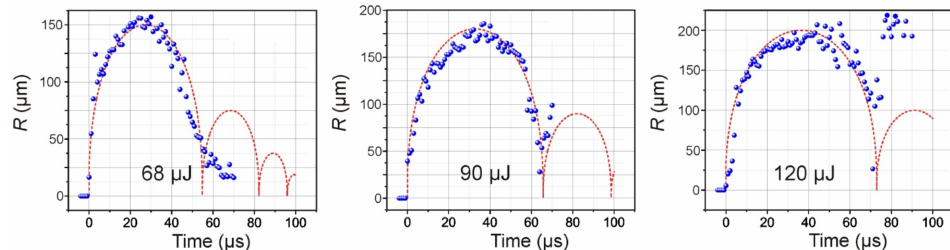
Figure 5. Time dependence of the diameter of a cavitation bubble in water at various laser pulse energies. Individual points were obtained by processing sequences of frames of time-resolving shadow microscope under the impact of laser pulses with τ = 8 ns on the absorbing Ti layer in Configuration 2 (Figure 1B). The red curves show the dependences of the bubble radii R ( t ) calculated by Formula (5) at different values of the initial pressure 41, 49 and 59 MPa respectively.